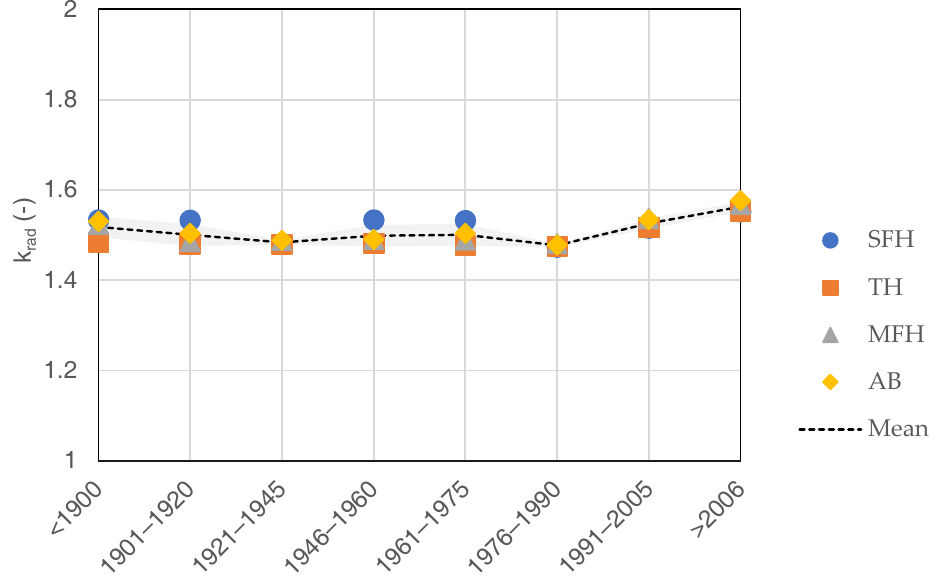
Figure 10. Radiator oversizing factor, k rad , for the different types of buildings as a function of construction